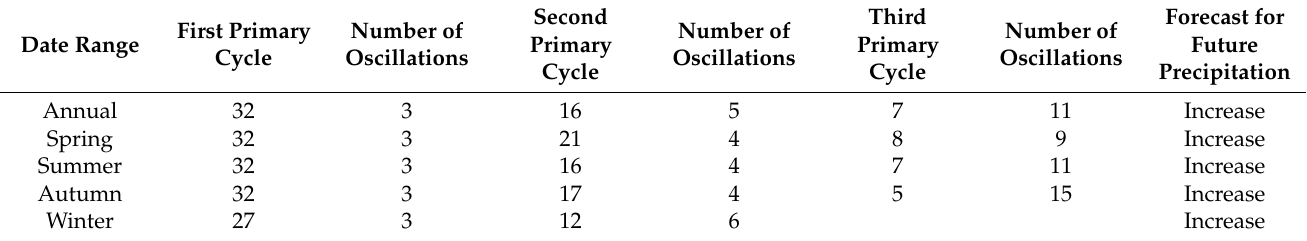
Table 2. Oscillatory variation of precipitation at different timescales on the TP in